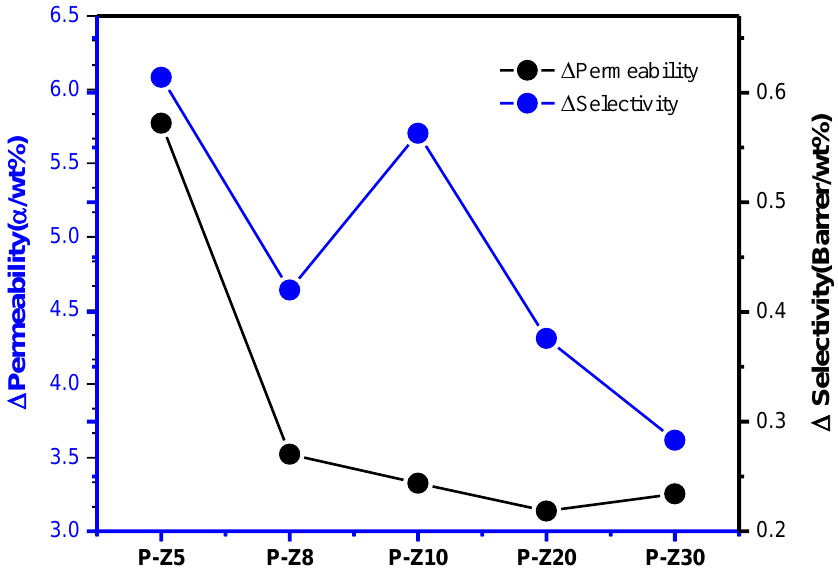
Figure 6. Pebax/n wt% ZIF-8 MMMs can improve the performance ratio per wt%.